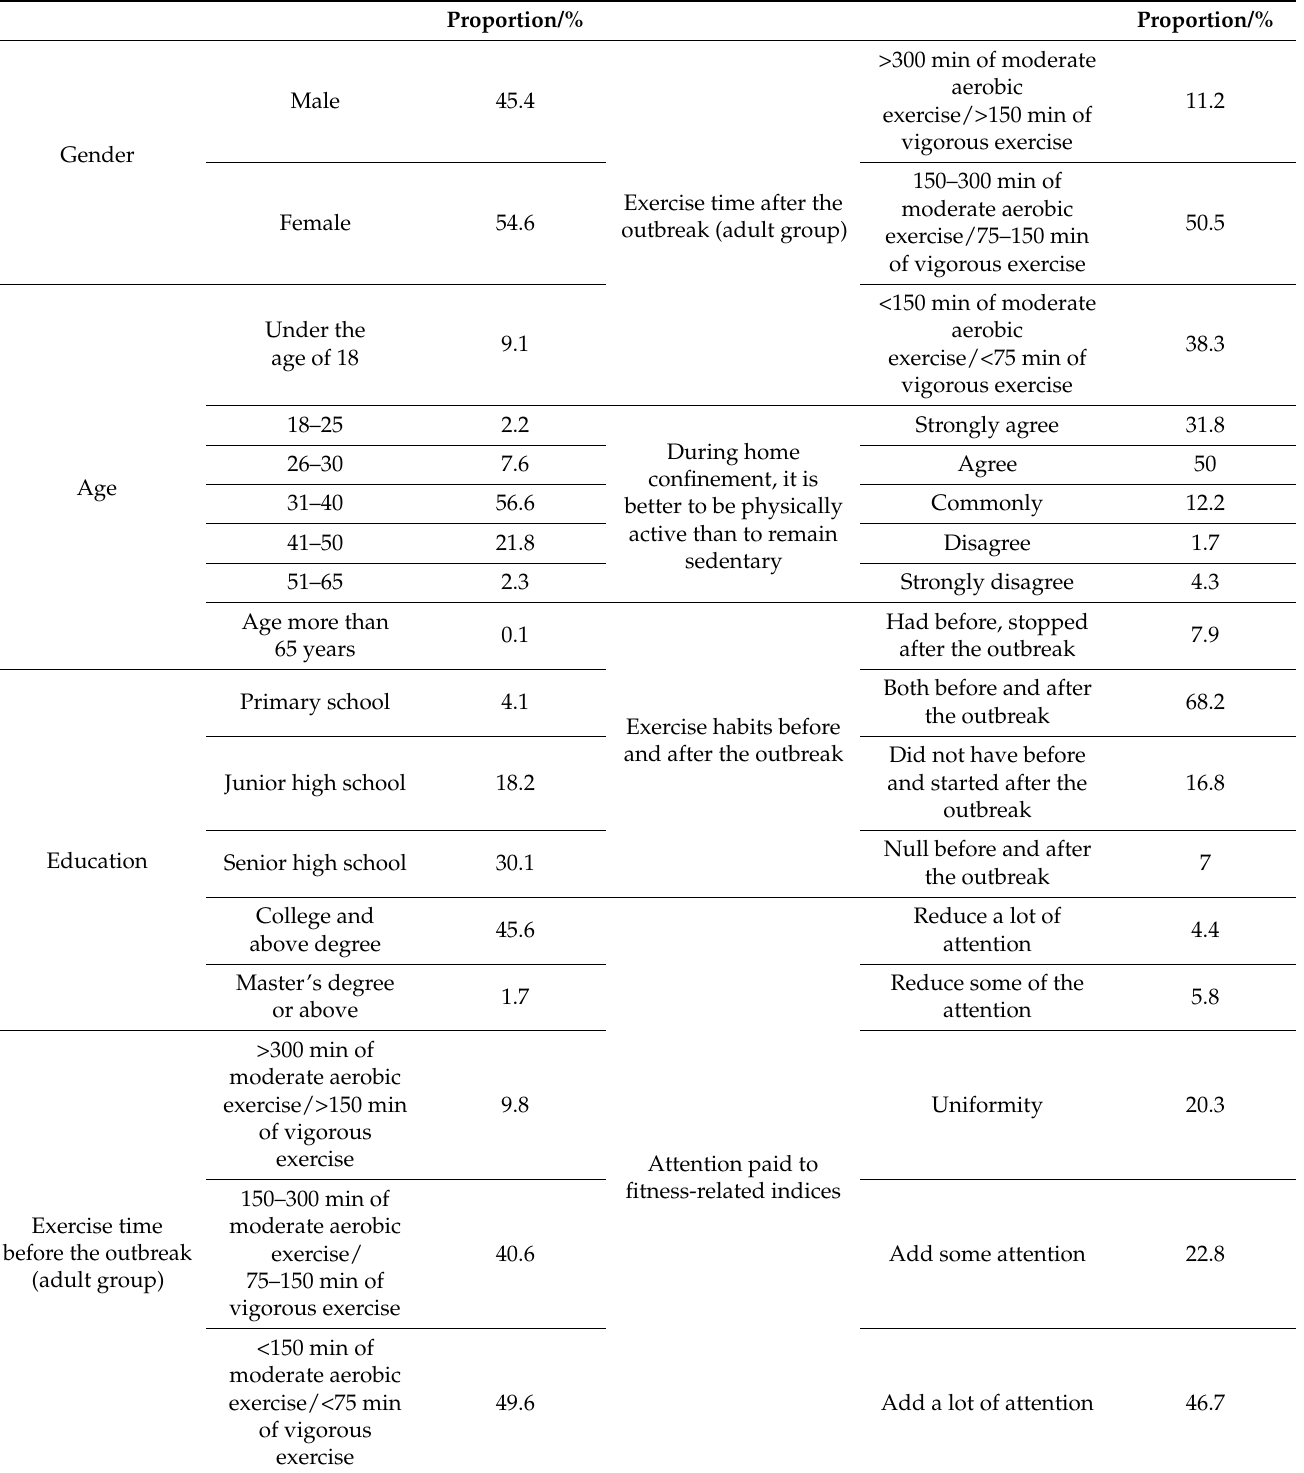
Table 1. Analysis of the demographic characteristics of the survey